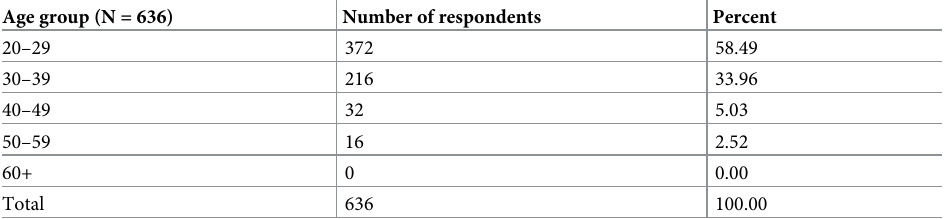
Table 2. Respondents’ age distribution at the study healthcare facilities, Addis Ababa City Administration, Febru- ary 2018.